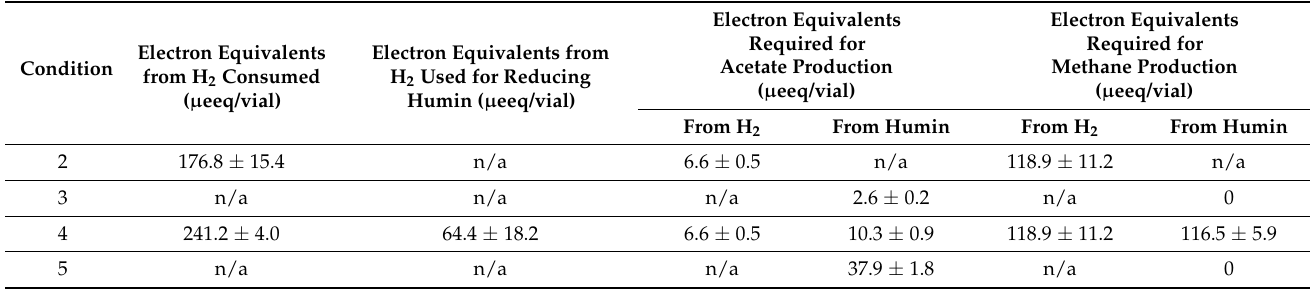
Table 2. Electron-donating capacity of H 2 , of humin in acetate, and of methane production.